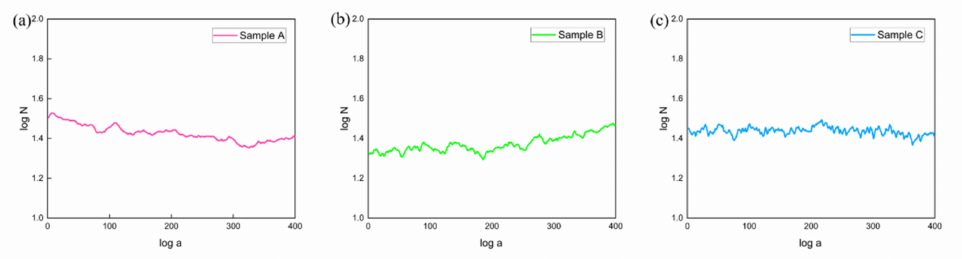
Figure 12. Calculation results of 2D fractal dimension of sample A ( a ), sample B ( b ) and sample C ( c